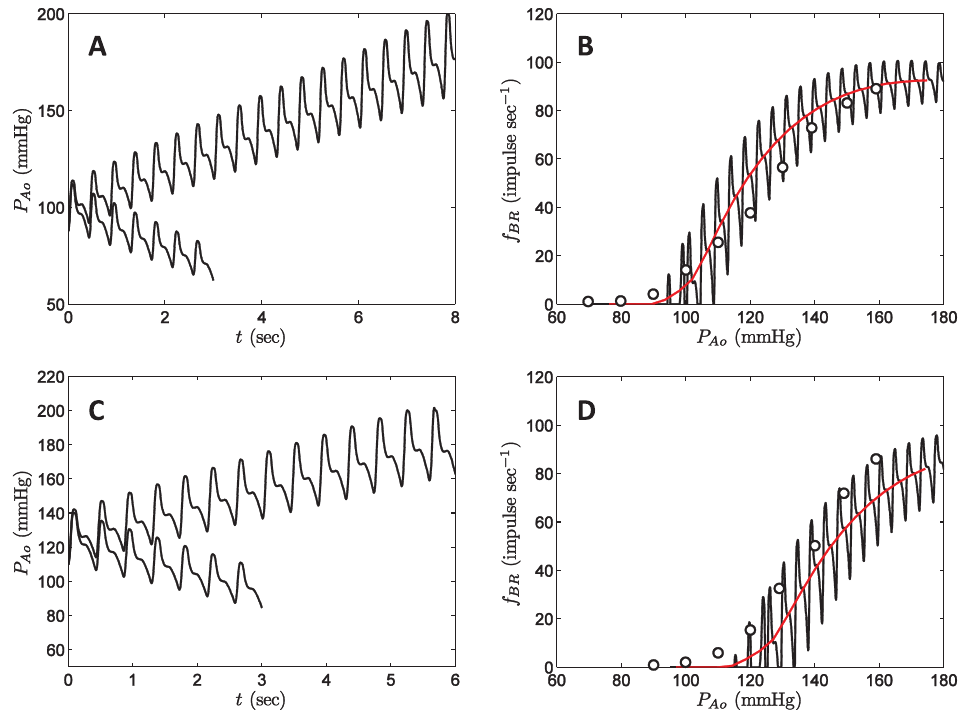
Figure 3. Baroreflex response to in vivo pressure ramps. A . Applied pressure transients for increasing and decreasing pressure starting at a baseline mean pressure of 100 mmHg. Pressure is increased/decreased so that the mean pressure changes at the rate of ±10 mmHg sec -1 . B . Simulated baroreceptor firing response to pressure ramps from A is compared to data from Coleridge et al. 11 . C . Applied pressure transients for increasing and decreasing pressure starting at a baseline mean pressure of 125 mmHg. D . Simulated baroreceptor firing response to pressure ramps from C is compared to data from Coleridge et al. 11 . See text for details on simulation protocol. In B and D , experimental data are plotted as circles; black line represents the simulation prediction; red line represents simulation predictions averaged over each heart